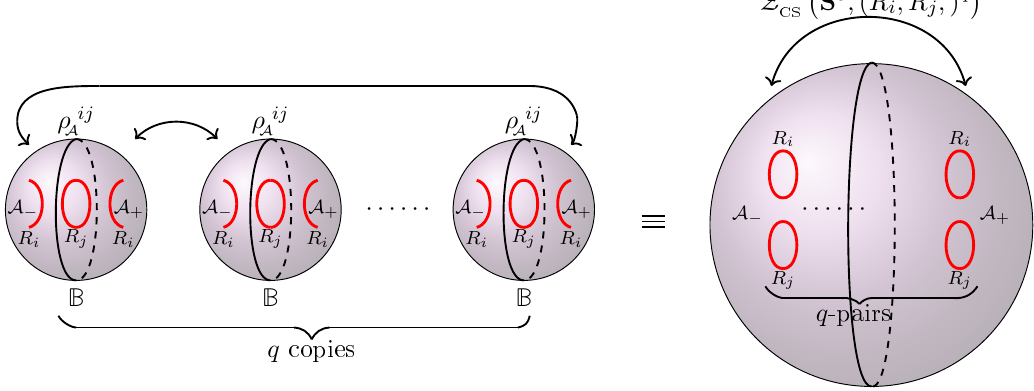
ij constructed in (cid:12)gure 18 glues q A ( S 3 ; ( R i ; R j ) q ) (cid:17) Z ( S 3 ; R i ; R j ; (cid:1) (cid:1) (cid:1) ; R i ; R j ), the CS CS